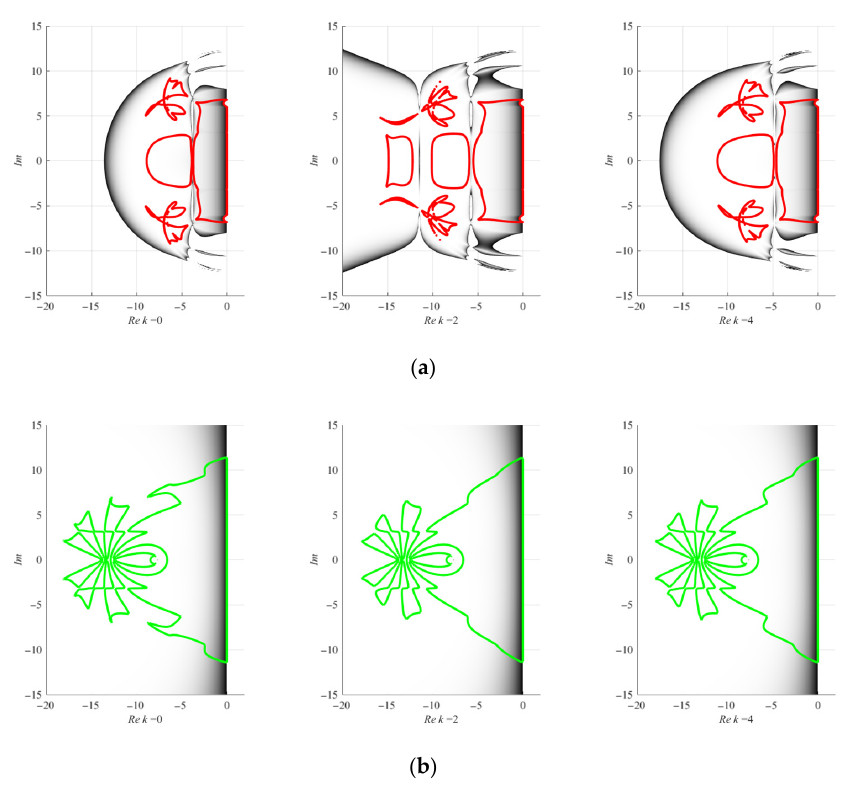
Figure 7. Stability and preference regions of XA6 composition scheme using the semi-implicit CD ( a ) and implicit midpoint ( b ) solvers as basic methods. ( a ) and implicit midpoint ( b ) solvers as basic